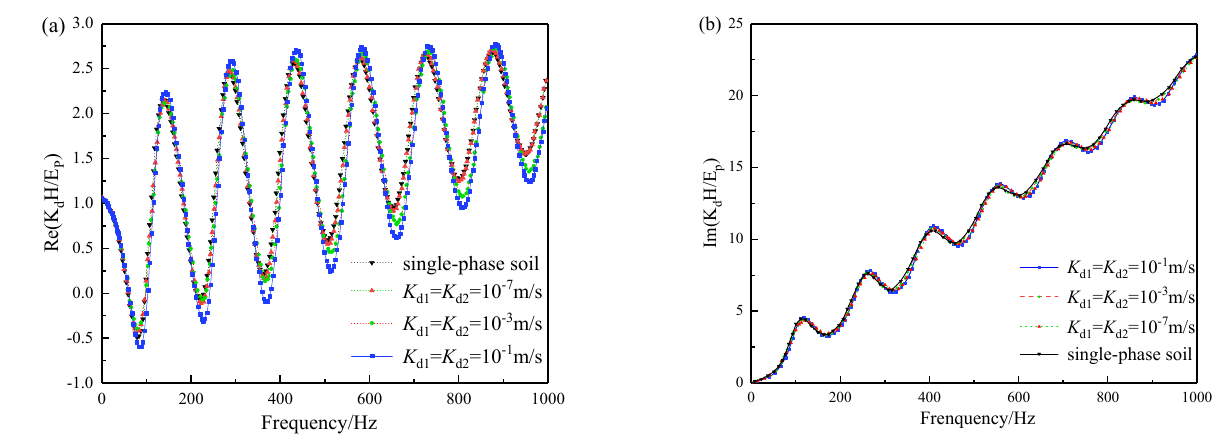
Figure 4. Influence of permeability of soil on pile impedance: ( a ) dynamic stiffness; ( b ) dynamic damping (reproduced from Liu et al. (2014) [38]).